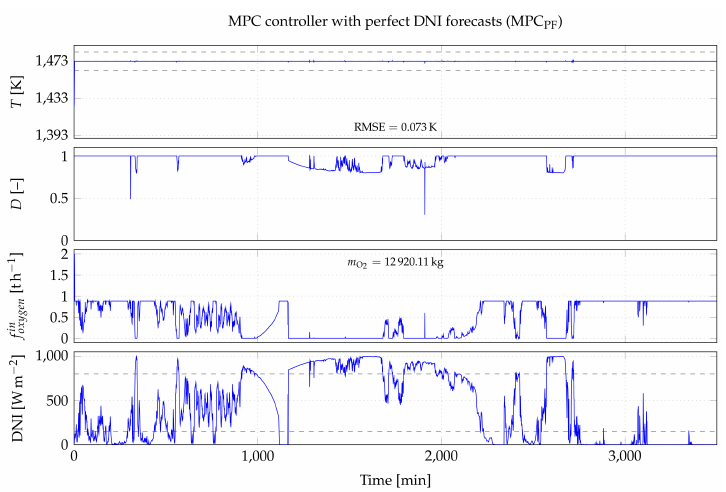
Figure 15. Case study results: reference (PID/RB) controller.